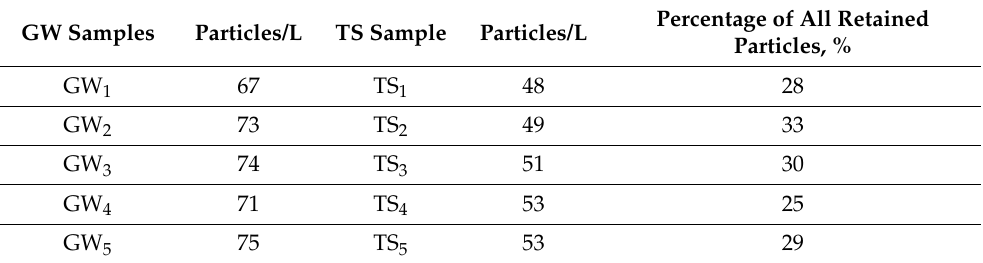
Table 2. Total number of microparticles per L of samples and the percentage of retained particles in a sewage treatment